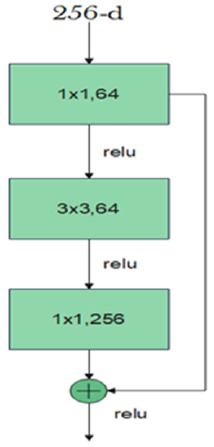
Figure 2. Residual block.